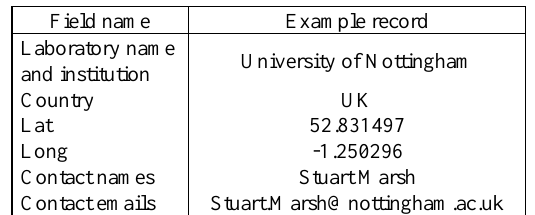
Table 1. Example data for triplification describing a name